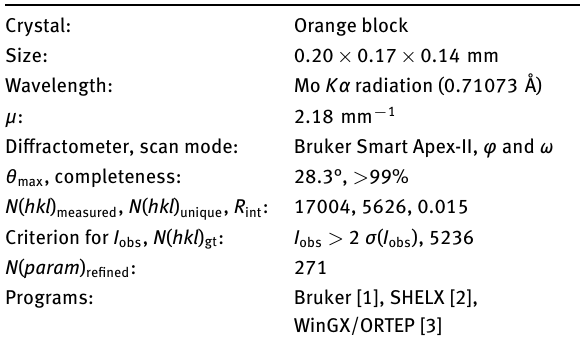
Table 1: Data collection and